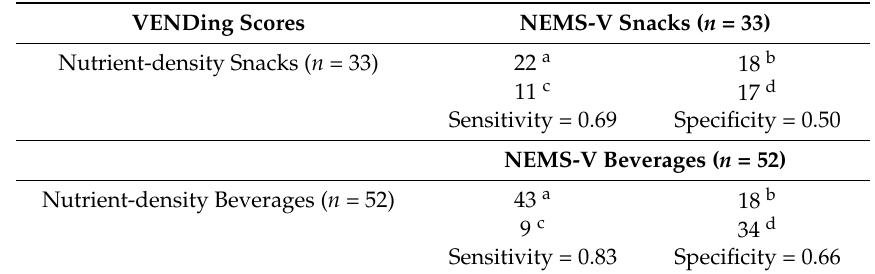
Table 8. Sensitivity and specificity of VENDing nutrient-density scores in comparison to